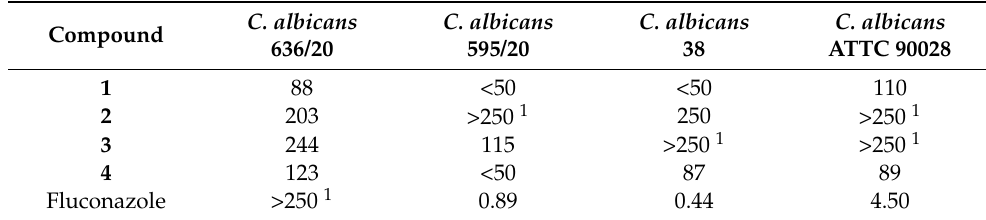
Table 3. Minimal inhibitory concentration (MIC 50 ) [ µ g/mL] for substrate ( 1 ), the product of its conversion: 3-butyl-3-hydroxyphthalide ( 2 ), its derivatives 3-butyl-3-methoxyphthalide ( 3 ) and 3- n -butylphthalide ( 4 ) when compared with that of